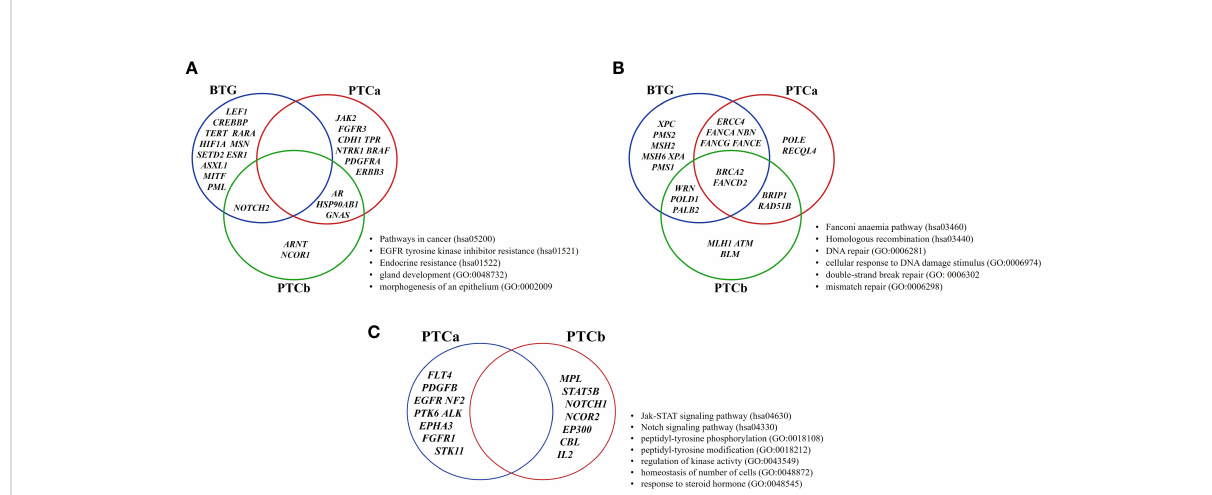
FIGURE 4 Distribution of genes of the enriched pathways in BTG, PTCa and PTCb. The enriched ontology terms are categorised according to the MCODE algorithm modules: (A) Cancer-related pathways and (B) DNA damage and repair-related pathways and (C) Signalling pathways. BTG, Benign thyroid goitre; PTCa, Papillary thyroid cancer without BTG background; PTCb, Papillary thyroid cancer with BTG